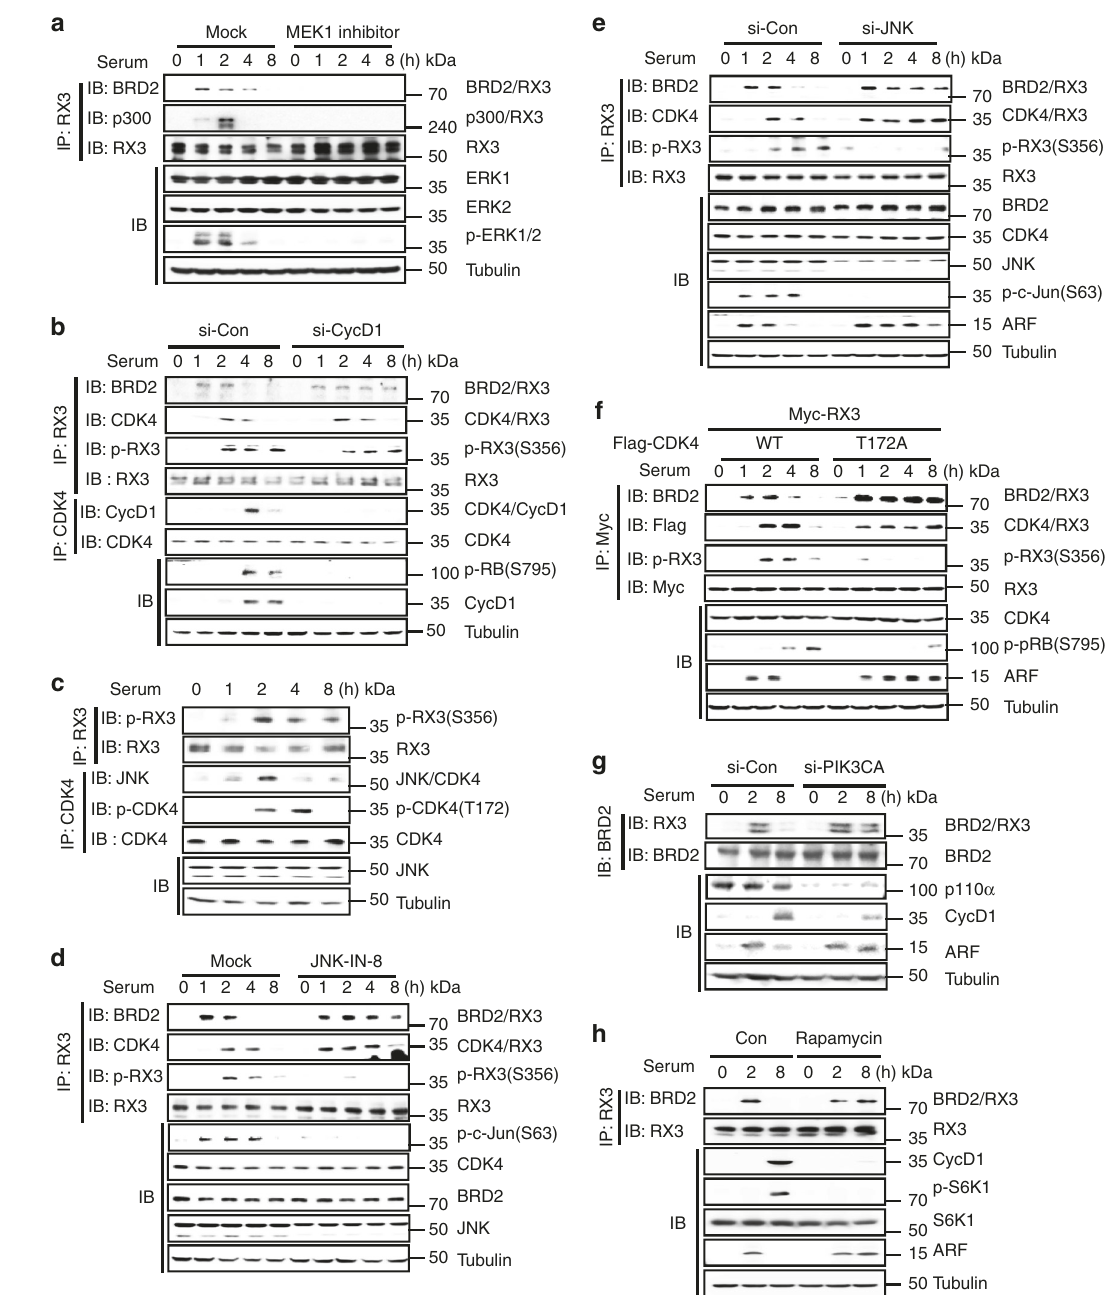
Fig. 5 Multiple signals contribute to the R-point transition. a HEK293 cells were treated with MEK1 inhibitor (U0126, 1 μ M). Time-dependent interactions of BRD2 – RUNX3 and p300 – RUNX3, as well as phosphorylation of ERK1/2, were monitored by IP and/or IB. b HEK293 cells were treated with control or CyclinD1-speci fi c siRNA (si-con or si-CycD1). Time-dependent formation of the BRD2 – RUNX3 and CDK4 – RUNX3 complexes and phosphorylation of RUNX3 at Ser-356 and pRB at Ser-795 were measured by IP and IB. c Time-dependent formation of the JNK-CDK4 complexes and phosphorylations of RUNX3 at Ser-356 and CDK4 at Thr-172 were measured by IP and IB. d HEK293 cells were treated with JNK inhibitor (JNK-IN-8, 1 μ M). Time-dependent formation of the BRD2 – RUNX3 and RUNX3 – CDK4 complexes and phosphorylation of RUNX3 at Ser-356 were measured by IP and IB. Time-dependent expression of ARF was measured by IB. e HEK293 cells were treated with control or JNK-speci fi c siRNA (si-con or si-JNK). Time-dependent formation of the BRD2 – RUNX3 and CDK4 – RUNX3 complexes and phosphorylation of RUNX3 at Ser-356 were measured by IP and IB. Time-dependent expression of ARF was measured by IB. f HEK293 cells were transfected with Myc-RUNX3 and Flag-CDK4 WT or Flag-CDK4-T172A (CDK4 mutant defective